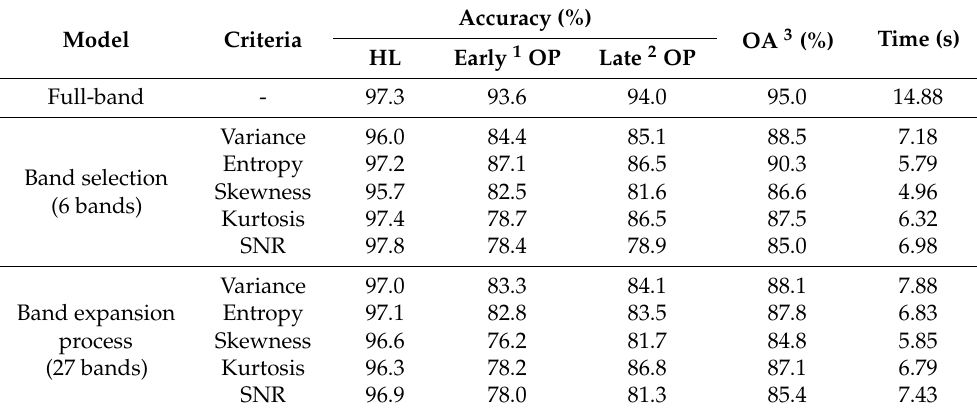
Table 2. Results for the testing dataset for DNN classification in different bands. The best performance is highlighted in